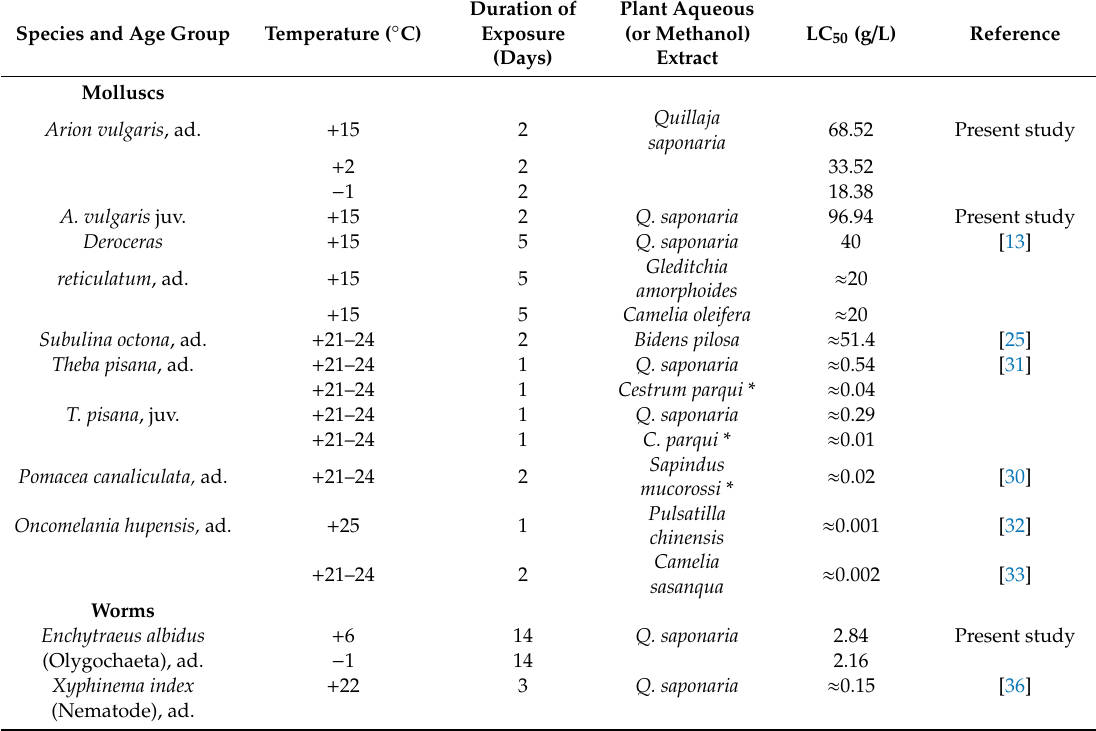
Table 3. Summary data for the toxicity of aqueous (or methanol) saponin extract from di ff erent plants for molluscs and